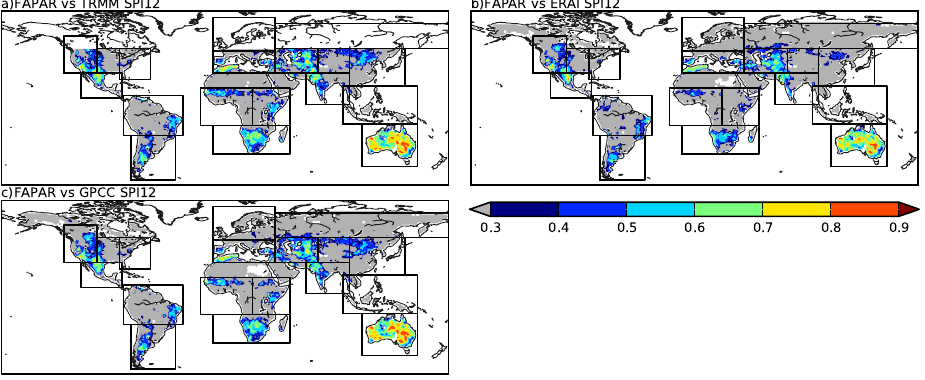
Figure 7. Temporal correlation of fAPAR (1999–2012) versus SPI-12 from (a) TRMM, (b) ERAI, and (c) GPCC. Correlations below 0.3 or not statistically significant different from zero (at 95%) are displayed as